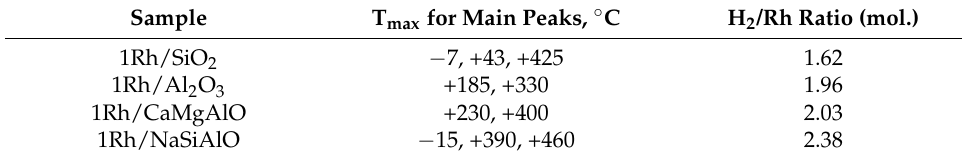
Table 5. TPR-H 2 results for non-reduced